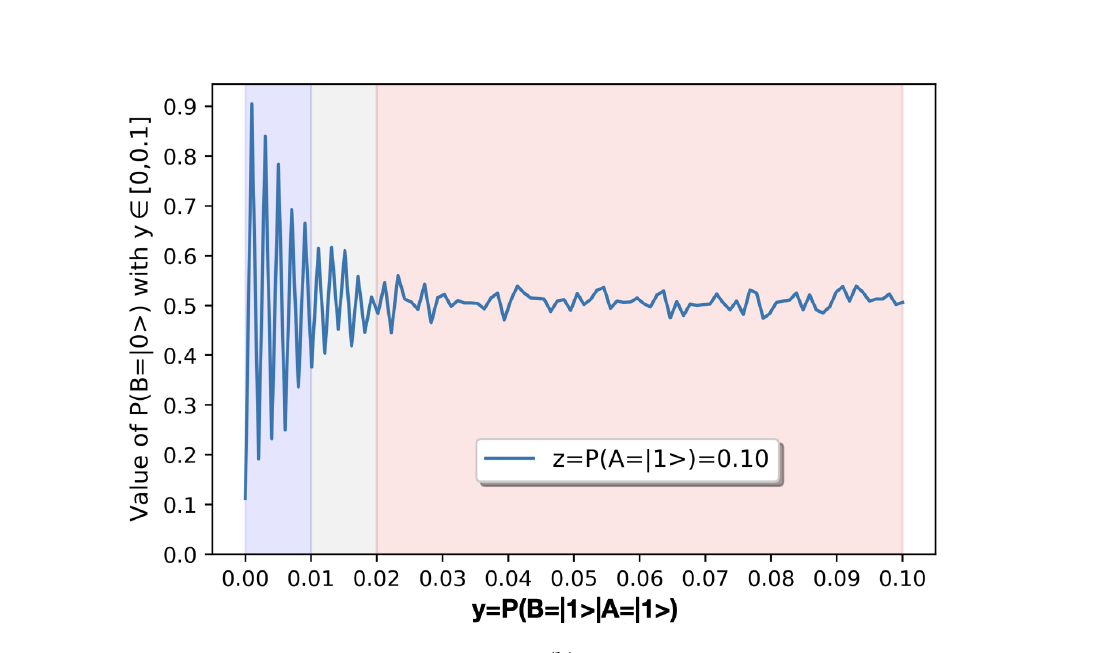
) for P ( A = 0 | (cid:105)